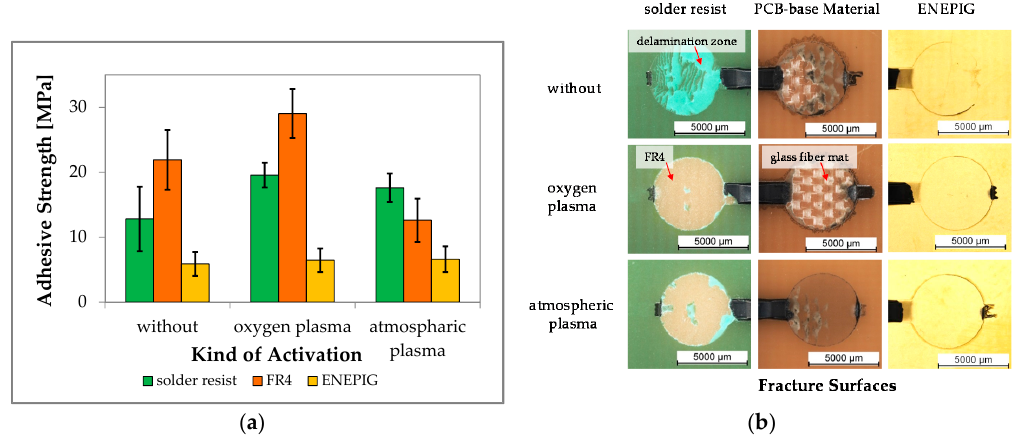
Figure 2. ( a ) The graphic shows adhesion strength in comparison to the kind of surface and activation. PCB-base materials demonstrate the highest adhesive strength in this investigation, and surface activation by means of oxygen plasma increases adhesive strength; ( b ) Presents the fracture surface of the different surfaces without and with plasma treatment. Polymeric surfaces exhibit cohesive fracture and metal surfaces show adhesive